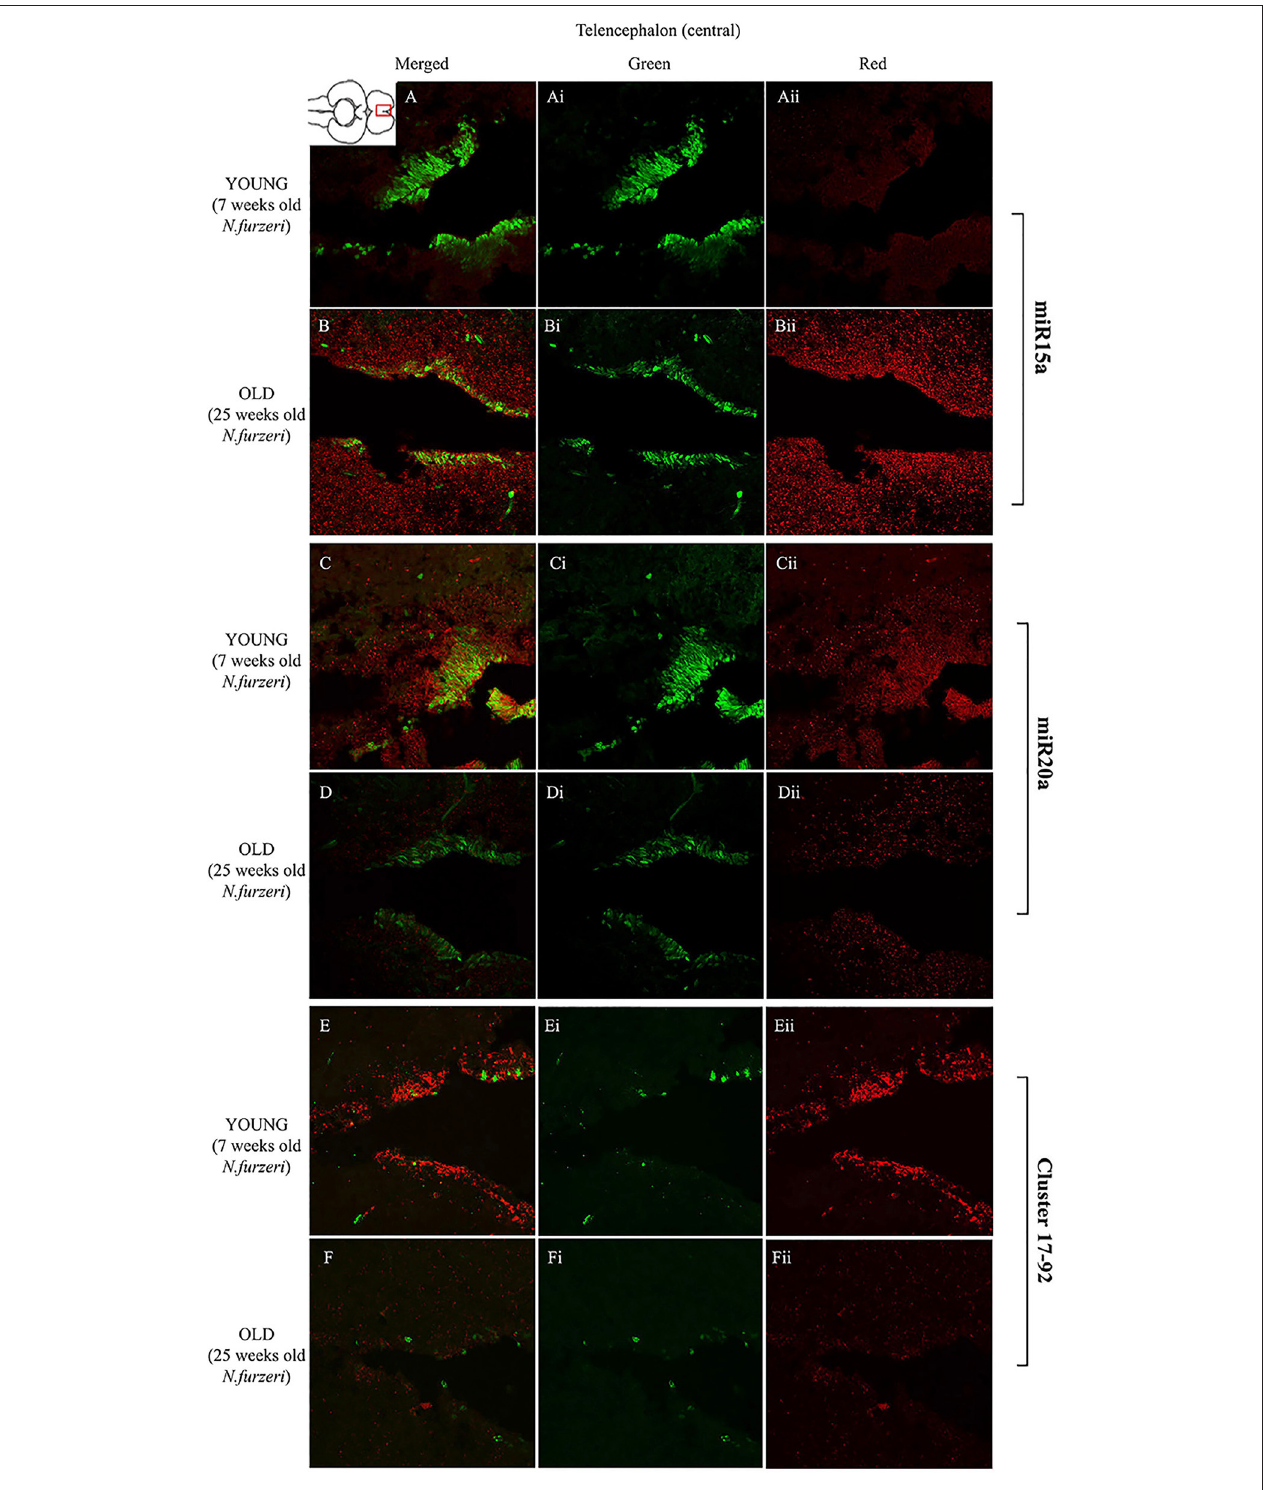
FIGURE 5 | Magnification of the latero-posterior region of the telencephalon (lpTEL) stained in green for PCNA by IHC, and in red for miR15 ( A,B strips), miR20 ( C,D strips), and Cluster17–92 ( E,F strips) by ISH. The lower inset on Aii shows an overview of a horizontal brain section: the location of the lpTEL is indicated by the red rectangle. The left column of the panel (A–F) shows the merged channels for the double staining; A,B refer to ISH for miR15a, respectively, in a young versus an old representative subject. C,D refer to ISH for miR20a, respectively, in a young versus an old representative subject. E,F refer to ISH for Cluster17–92, respectively, in a young versus an old representative subject. Central (Ai–Fi) and right (Aii–Fii) columns show the green and red single channel of the respective image on the left.